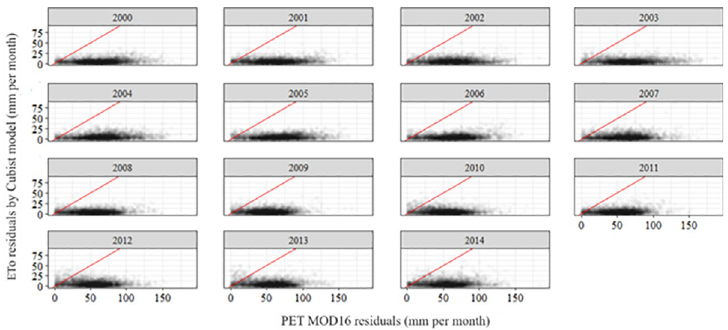
Fig 4. Yearly residual of MOD16 PET compared to the yearly residual of ETo modeled by Cubist algorithm.